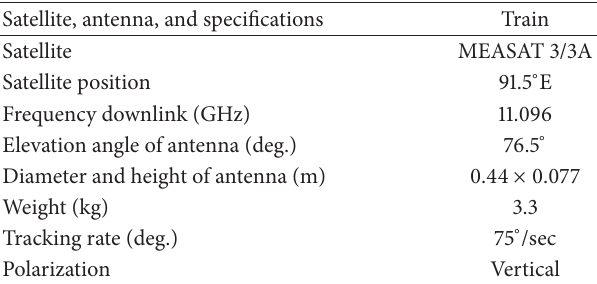
Table 2: Satellite, antenna, and site specifications for mobile termi- nals.